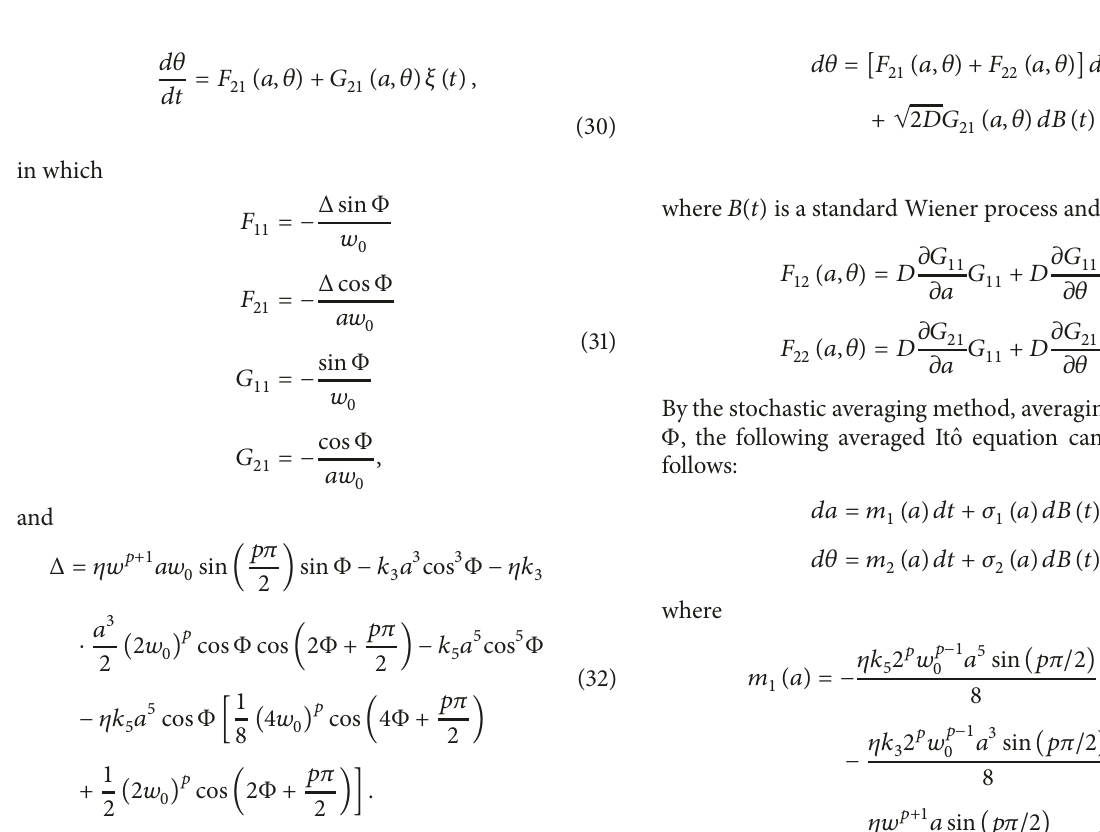
Figure 3: Phase diagrams of system (28) at 𝐷 = 0